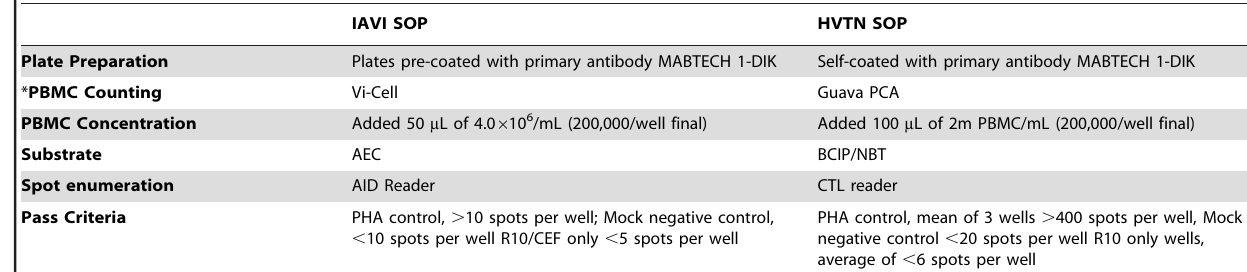
Table 1. Differences between SOPs.